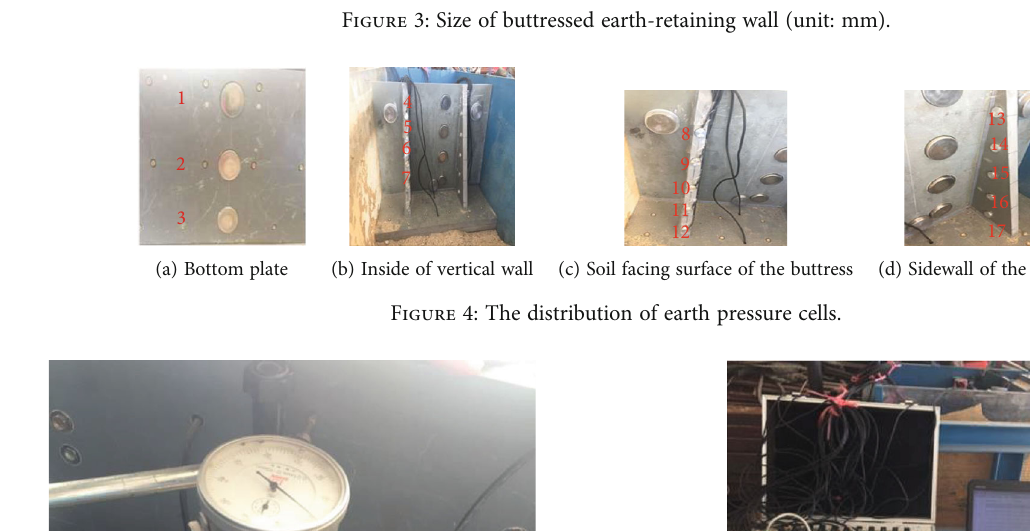
Figure 3: Size of buttressed earth-retaining wall (unit: mm).